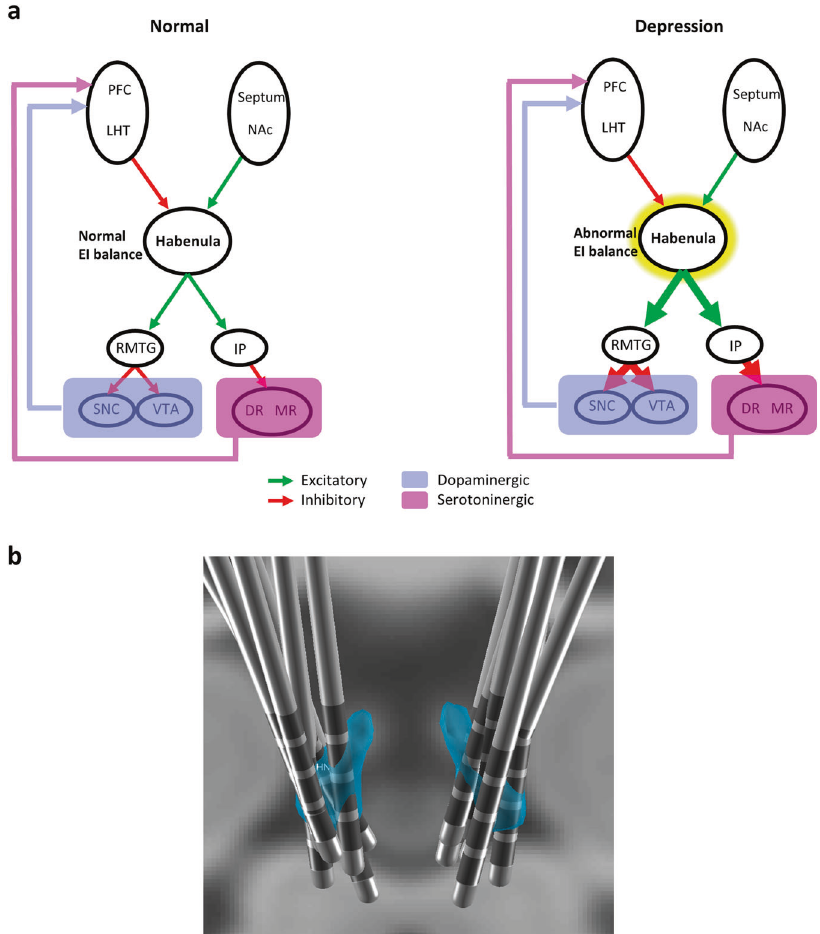
Fig. 1 Habenula circuitry and electrode localisation. a left- simplistic illustration of normal excitatory and inhibitory connections of habenula and their downstream neurotransmitter pro fi le, right — hyperactive habenula in depression with increased excitation-inhibition (EI) balance leading to greater downstream effects (shown in thickened arrows). For detailed connections of the habenula see [13, 74 – 76]. PFC — prefrontal cortex, LHT — lateral hypothalamus; NAc — nucleus accumbens; RMTG — rostromedial tegmental region; IP — interpeduncular nucleus; SNC — substantia nigra pars compacta; VTA — ventral tegmental area; DR- dorsal raphe nuclei, MR — medial raphe nuclei b electrode locations reconstructed using Lead-DBS with habenula represented in